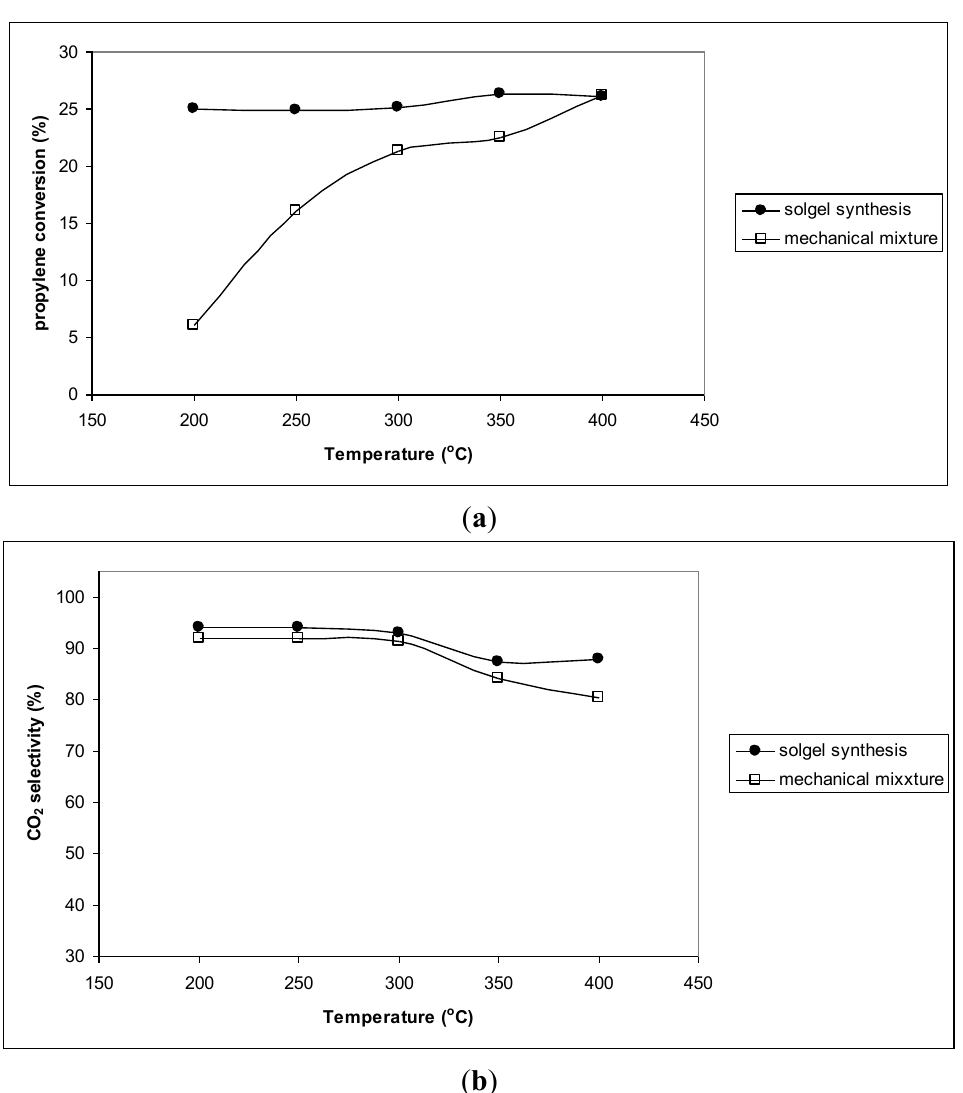
Figure 7. ( a ) Propylene conversion (%) and ( b ) CO 2 selectivity (%) of the mixture containing 50 mol% CeO 2 and 50 mol% Co 3 O 4 synthesized by mechanical mixing and sol-gel method at different reaction